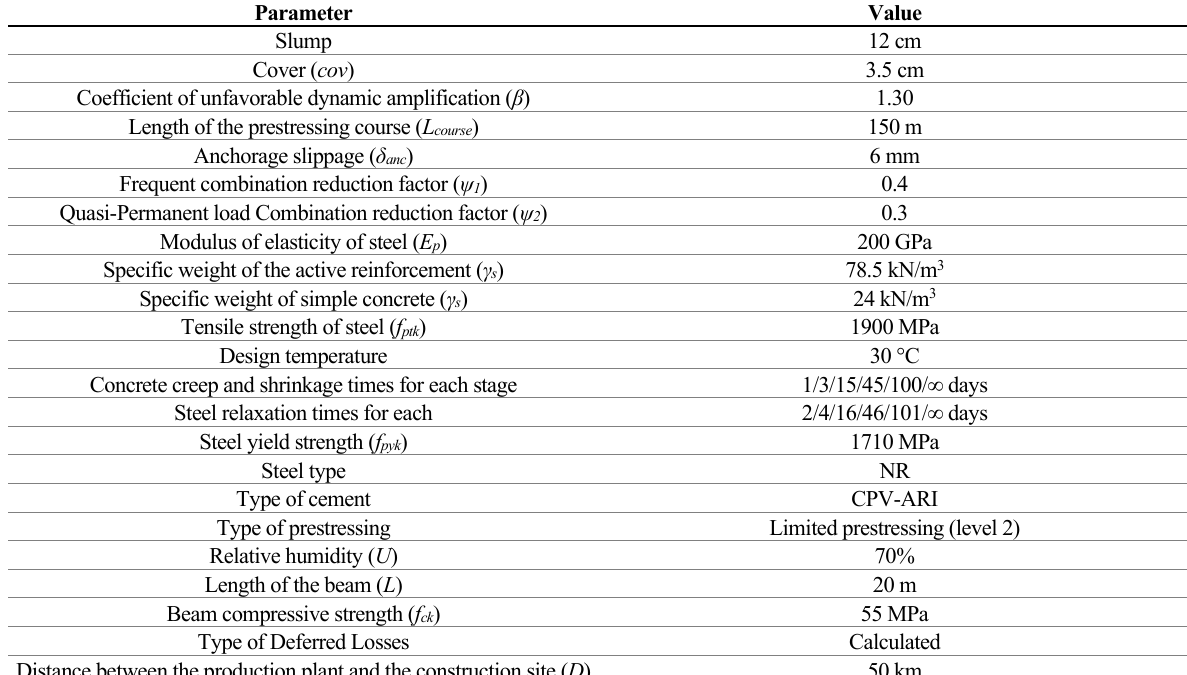
Table 4. Fixed parameters of the concrete beam